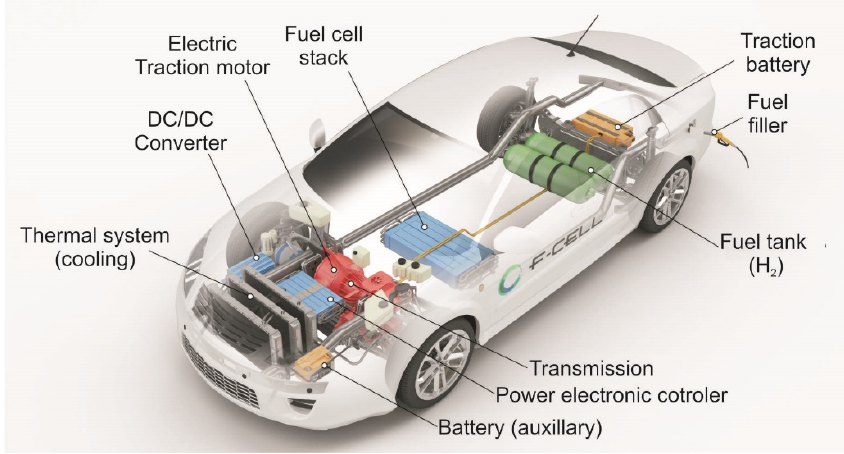
Figure 9. Structural diagram of a passenger car drive system with a PEM fuel cell adapted to hydrogen supply and high-pressure tanks [15].